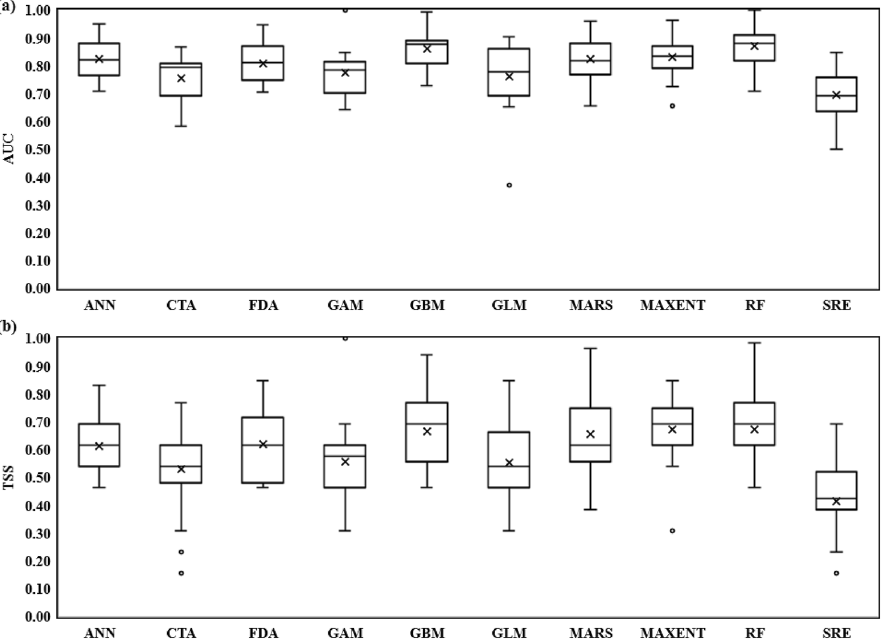
Figure 3. The indices of the AUC (Area Under Curve: ( a ), and the TSS (True Skill Statistic: ( b ) of ten modeling methods (ANN: Artificial Neural Network, CTA: Classification Tree Analysis, FDA: Flexible Discriminate Analysis, GAM: Generalized Additive Model, GBM: Generalized Boosted Model, GLM: Generalized Linear Model, MARS: Multivariate Adaptive Regression Splines, MaxEnt: Maximum Entropy, RF: Random Forest, and SRE: Surface Range Envelope) for predicting S. inflata distribution during the current periods.